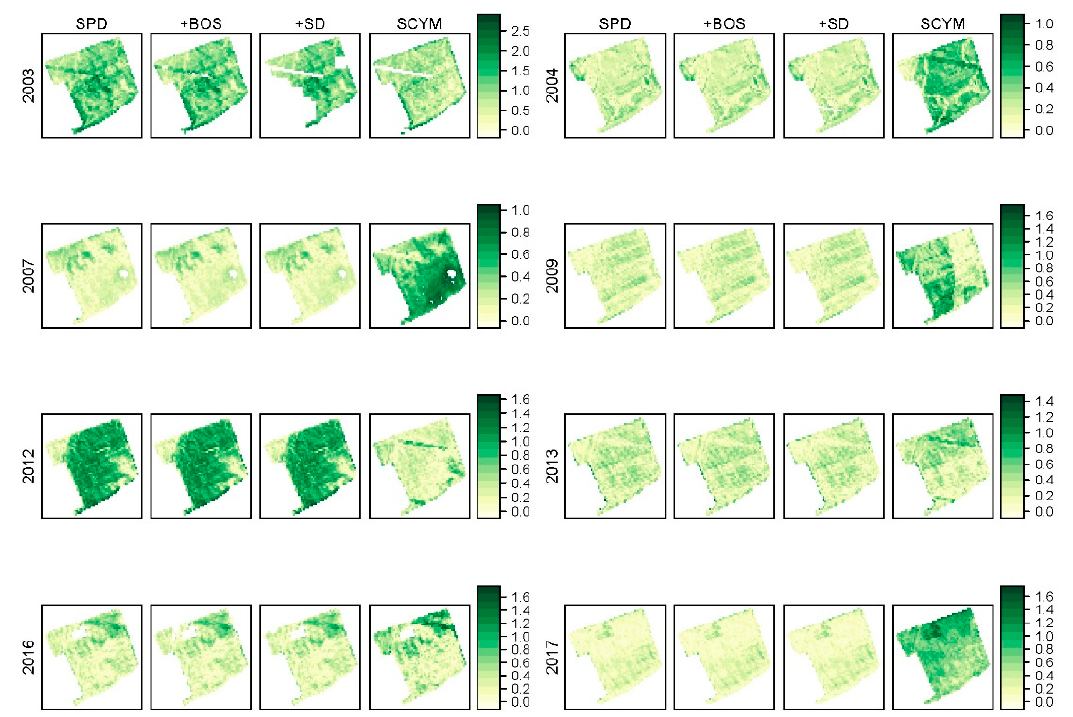
Figure 7. The absolute yield difference (tonnes/ha) between actual and estimated using each of the four models: statistical phenology detection (SPD), statistical phenology detection incorporates break of season (+BOS), statistical phenology detection incorporates sowing date (+SD), and scalable crop yield mapper (SCYM).